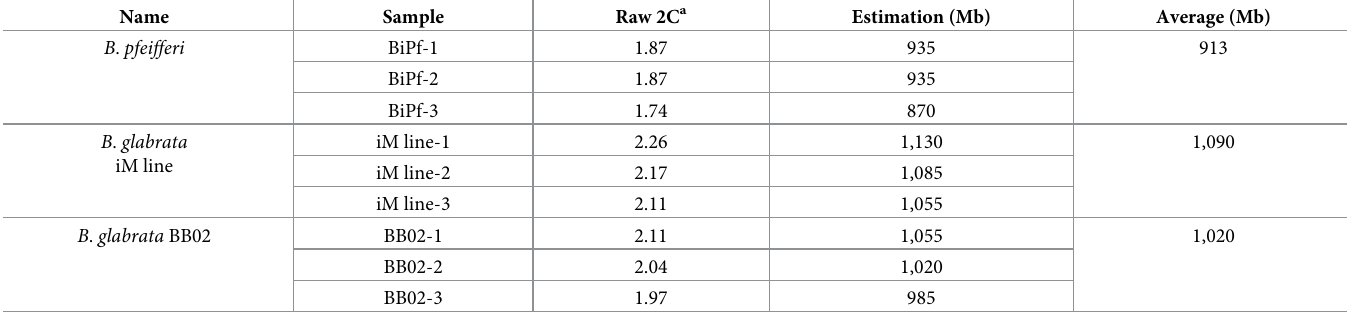
Table 3. Estimation of genome size based on fluorescence cell sorting intensity in comparison with known standards.